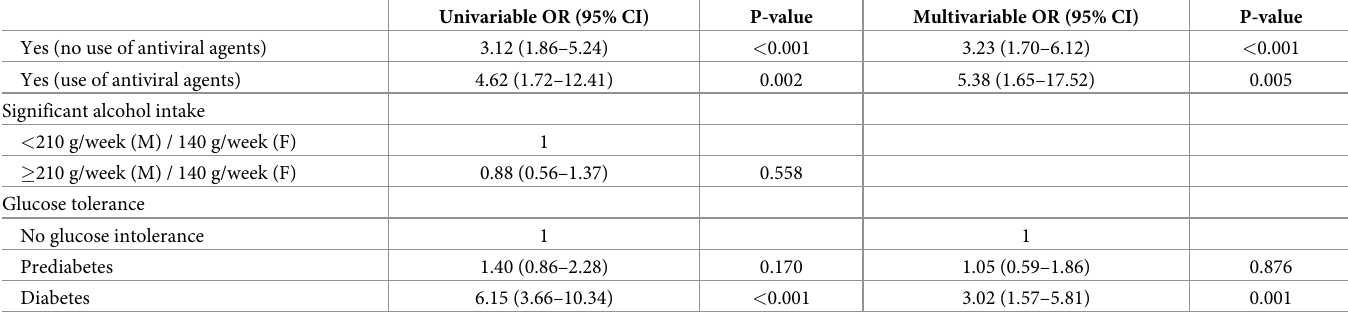
count � 160 x10 3 /mm 2 (OR, 6.25; 95% CI, 3.29–11.86; p < 0.001), viral hepatitis without the use of antiviral agents (OR, 3.23; 95% CI, 1.70–6.12; p < 0.001), viral hepatitis with the use of antivi- ral agents (OR, 5.38; 95% CI, 1.65–17.52; p = 0.005), and diabetes (OR, 3.02; 95% CI, 1.57– 5.81; p = 0.001). However, there was no significant relationship between prediabetes and sig- nificant fibrosis in the univariable and multivariable analyses (OR, 1.40; 95% CI, 0.86–2.28; p = 0.170 and OR, 1.05; 95% CI, 0.59–1.86; p = 0.876, respectively). We additionally